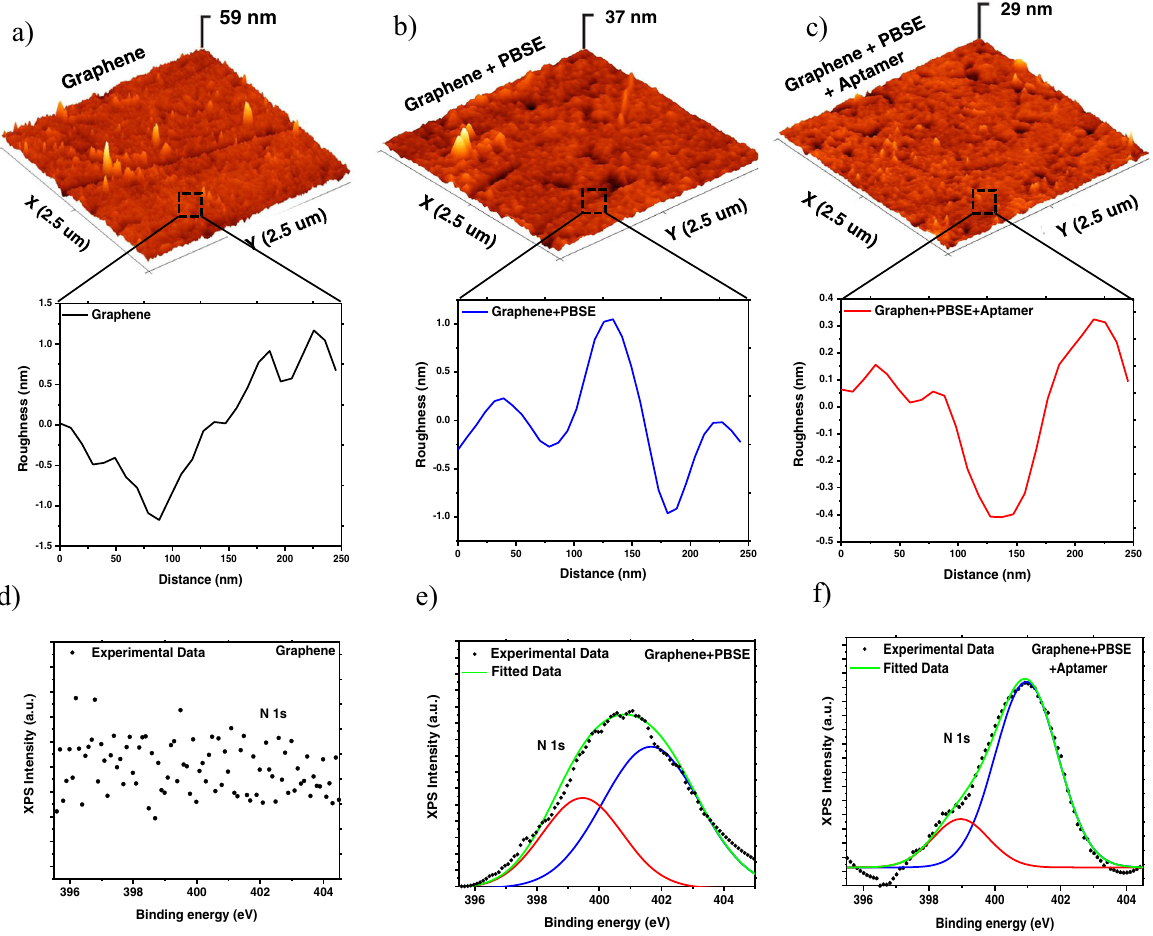
Fig. 3 AFM 3D morphology of the Pt electrode and XPS characterization. a After the graphene transfer, b after the PBSE linking, c after the aptamers functionalization. d – f Corresponding XPS graphs and fi tting for different functionalization of the Pt